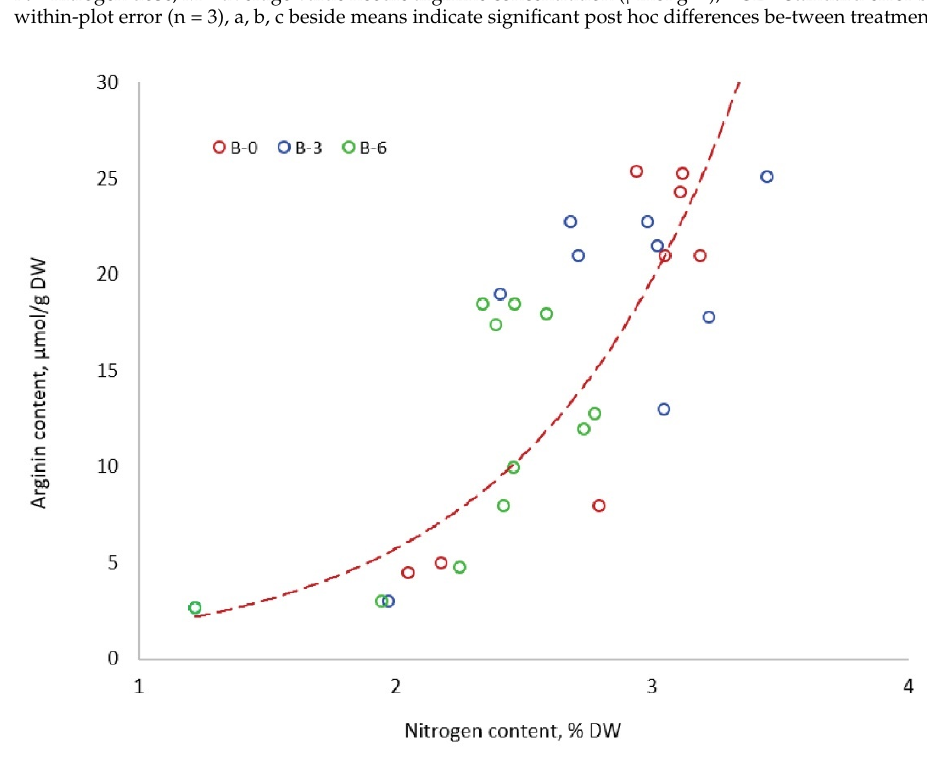
Figure 5. Dependence of the accumulation of arginine in the needles of Pinus sylvestris L. on the nitrogen content on three backgrounds of boron supply. B0, B3, B6—boron doses of 0, 3.0, 6.0 kg ha − 1 , respectively. September 2014.